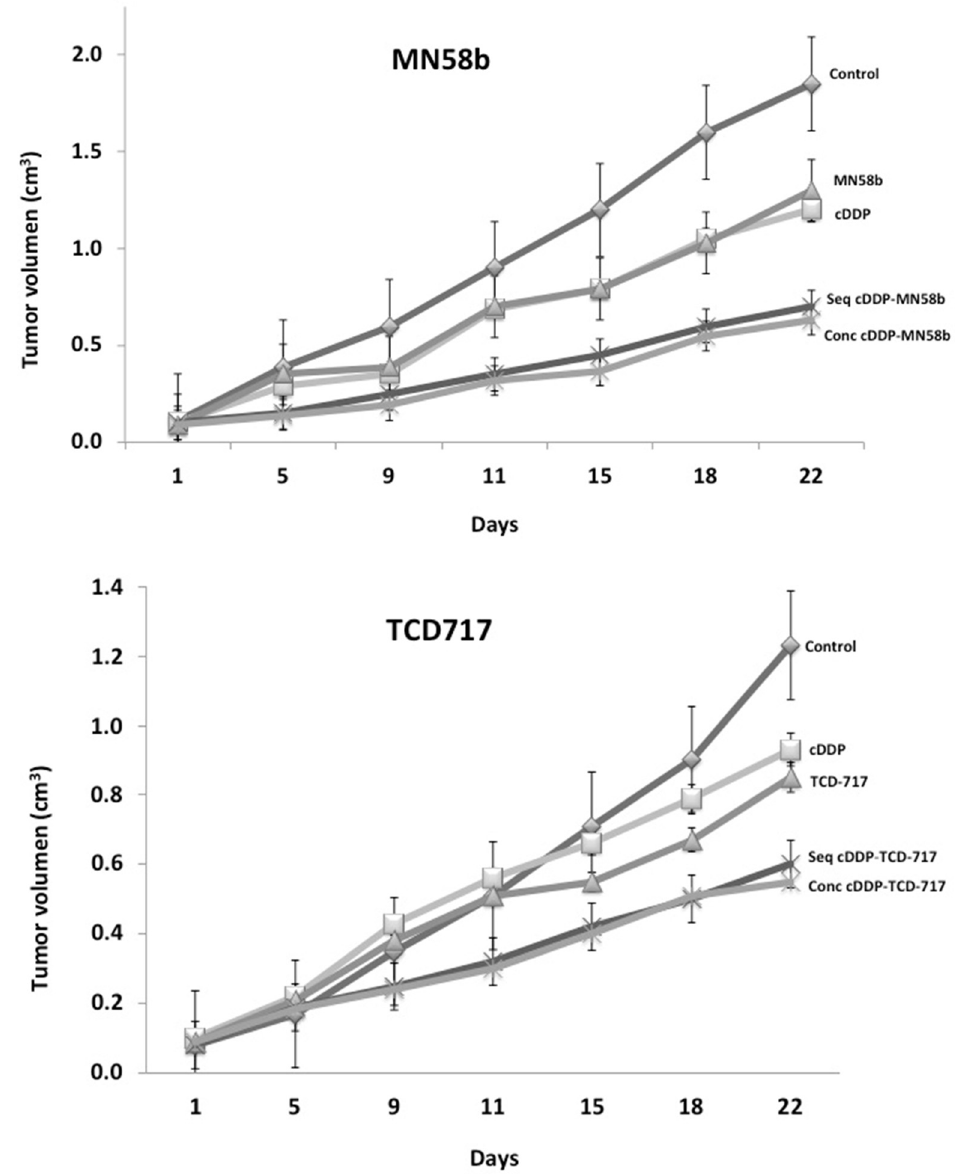
Figure 4. Tumor growth inhibition on H460 xenografts by combination of MN58b or RSM-932A/TCD-717 and cisplatin. H460 cells were injected in nude mice, and when tumor volumes reached 0.1 cm 3 , animals were randomly distributed in groups ( n = 8) to start treatments. Mice were treated with the indicated ChoK α and cisplatin (cDPP) either alone or following sequential or concomitant schedules. A significant synergistic effect was observed with the combined therapy in both cases: MN58b (upper) and RSM-932A/TCD-717 (lower).